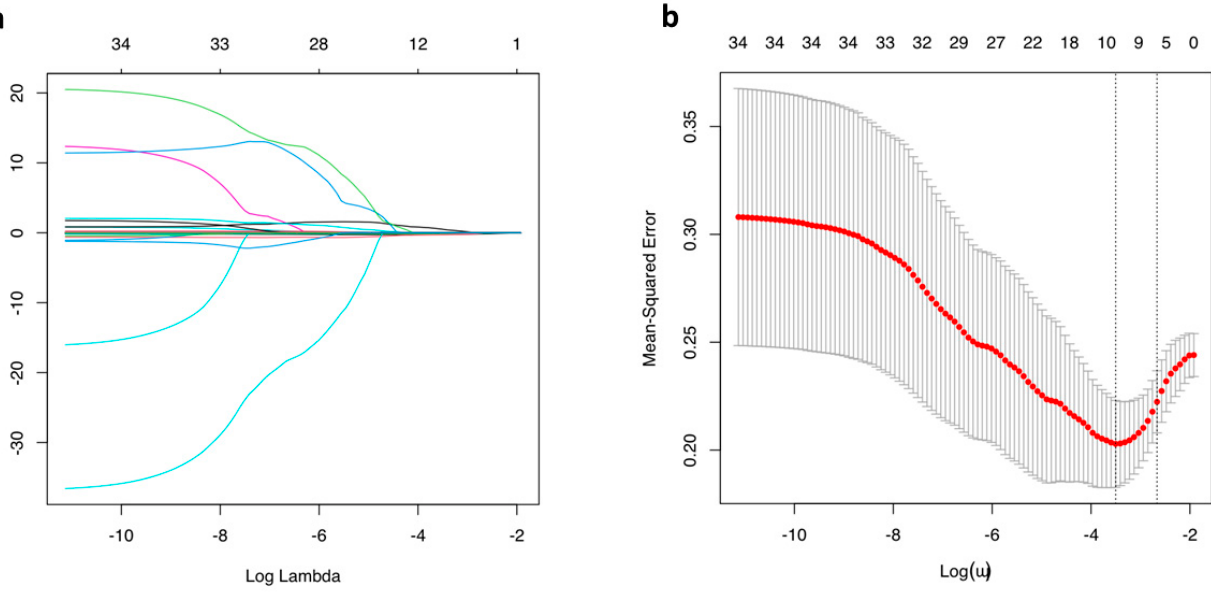
Figure 3. Comparison of patients without any molecular alteration and patients with at least one in terms of all positron emission tomography quantitative variables included in the model. 3.4. Relationship between Variables Included in the Lasso Regression Model